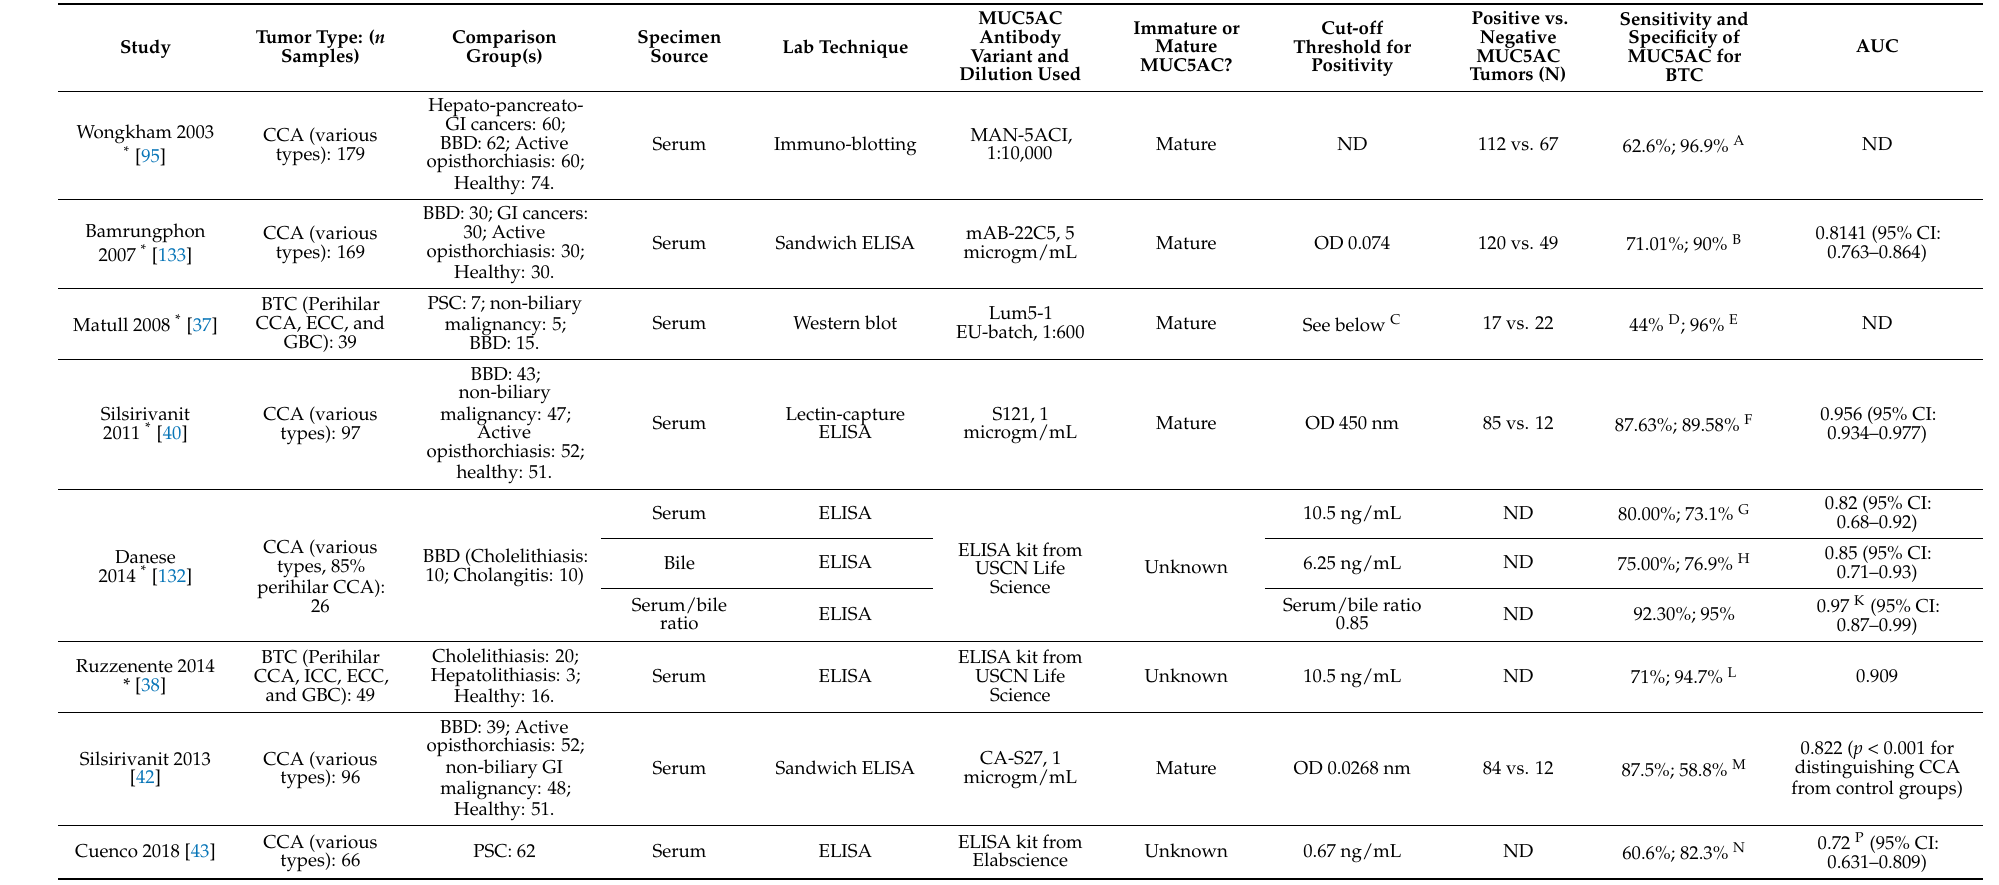
Table 3. Studies analyzing the diagnostic performance of serum MUC5AC for